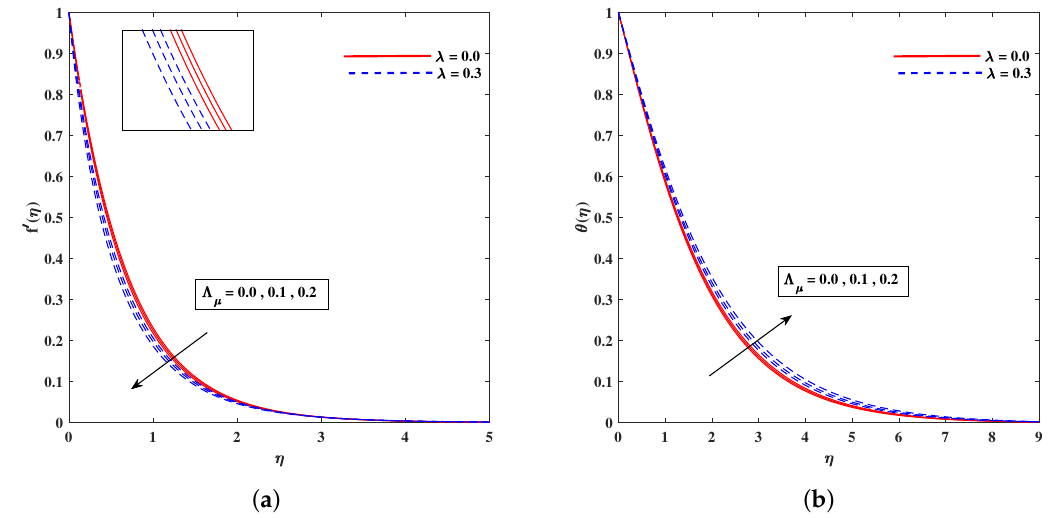
Figure 7. Fluctuation of Λ µ on velocity f (cid:48) ( η ) ( a ) and temperature profile θ ( η ) ( b